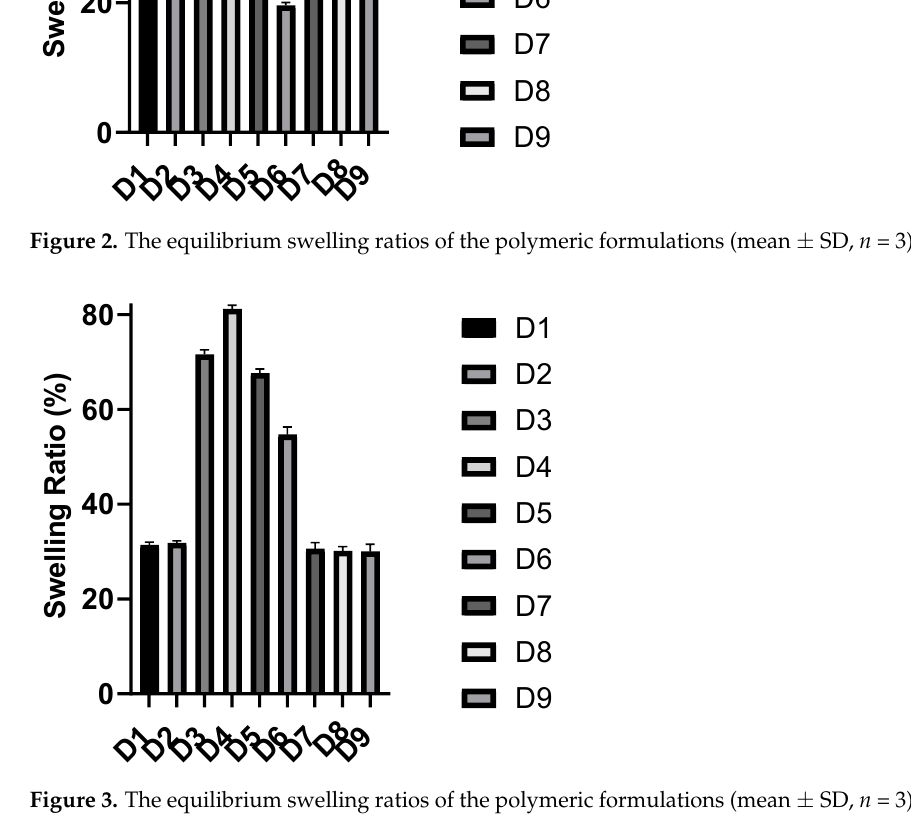
Figure 3. The equilibrium swelling ratios of the polymeric formulations (mean ± SD, n = 3) at pH 7.4. Table 5. The swelling rate constants ( k ) and R 2 obtained from fitting to the Korsmeyer–Peppas model.